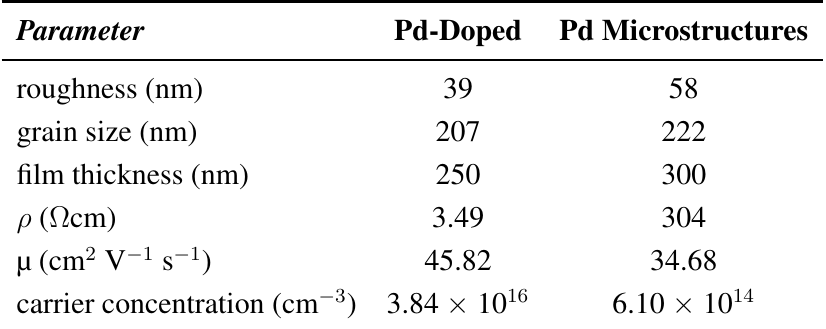
Table 1. Thin film comparative characteristics for the active